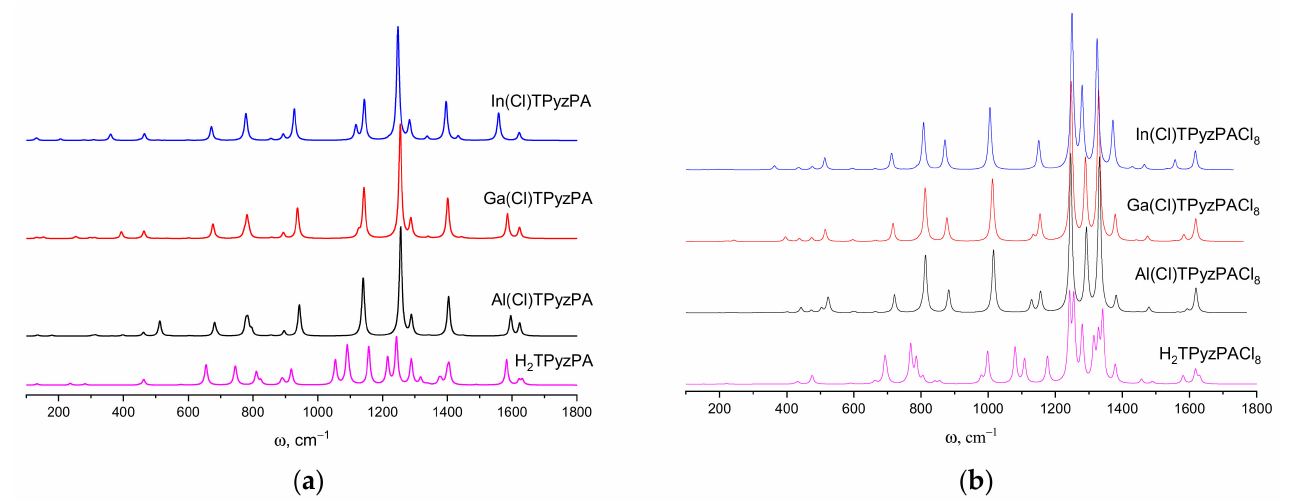
Figure 5. Calculated IR spectra of M(Cl)TPyzPA ( a ) and M(Cl)TPyzPACl 8 ( b